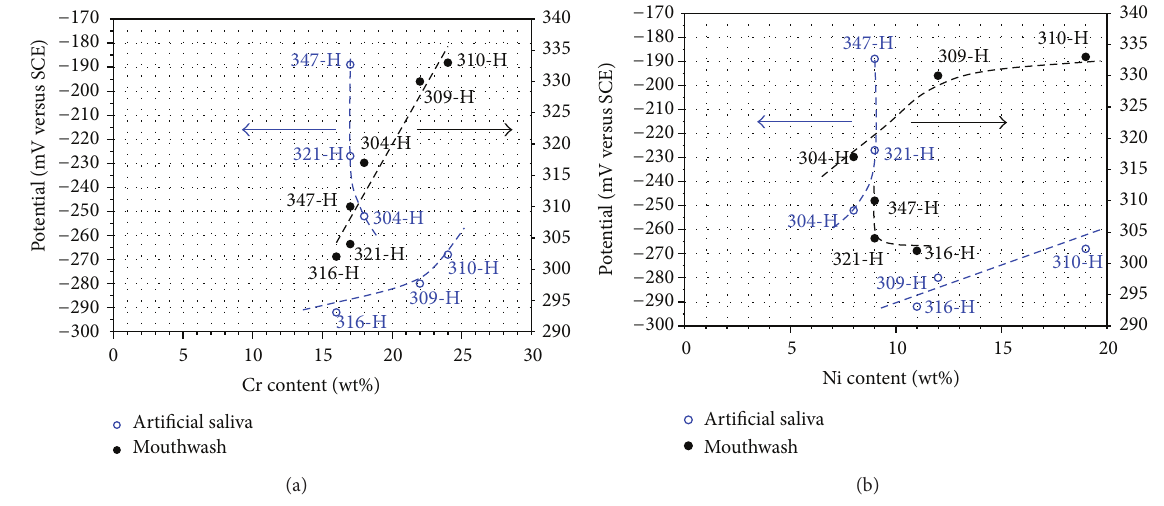
Figure 3: Effect of Cr and Ni content of stainless steels on 𝐸